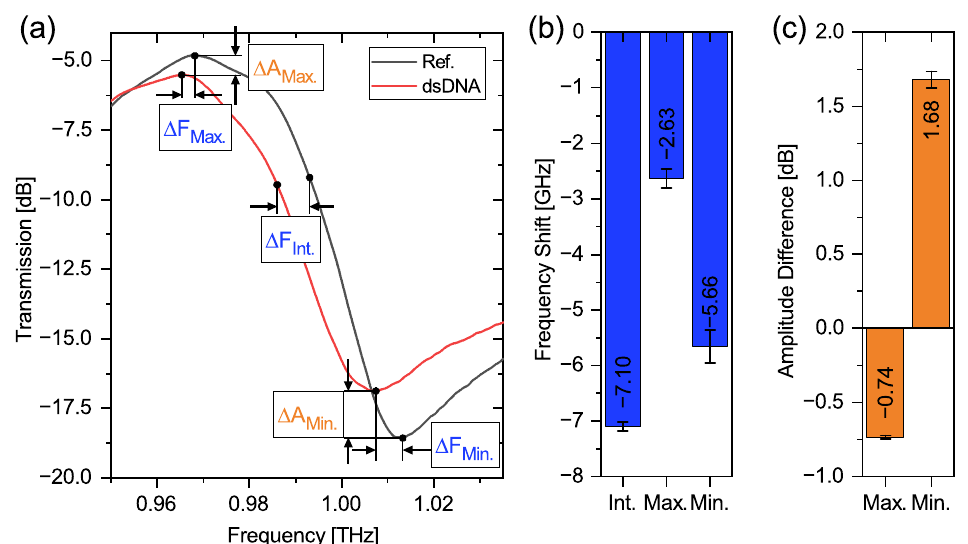
Figure 4. Parametric evaluation of the DRF, using an example measurement with the 1THz biosensor with 30 pmol dsDNA. The transmission spectra of the reference and dsDNA measurement are featured in ( a ). The extracted parameters are highlighted in ( b , c ). ( b ) shows the frequency shift as a result of the dsDNA loading at the intersection point of the slope ∆ F Int. , the maximum position ∆ F ∆ F Max. and minimum position Min. . ( c ) shows the amplitude difference between the reference and the dsDNA at the maximum position ∆ A Max. and minimum position ∆ A Min.